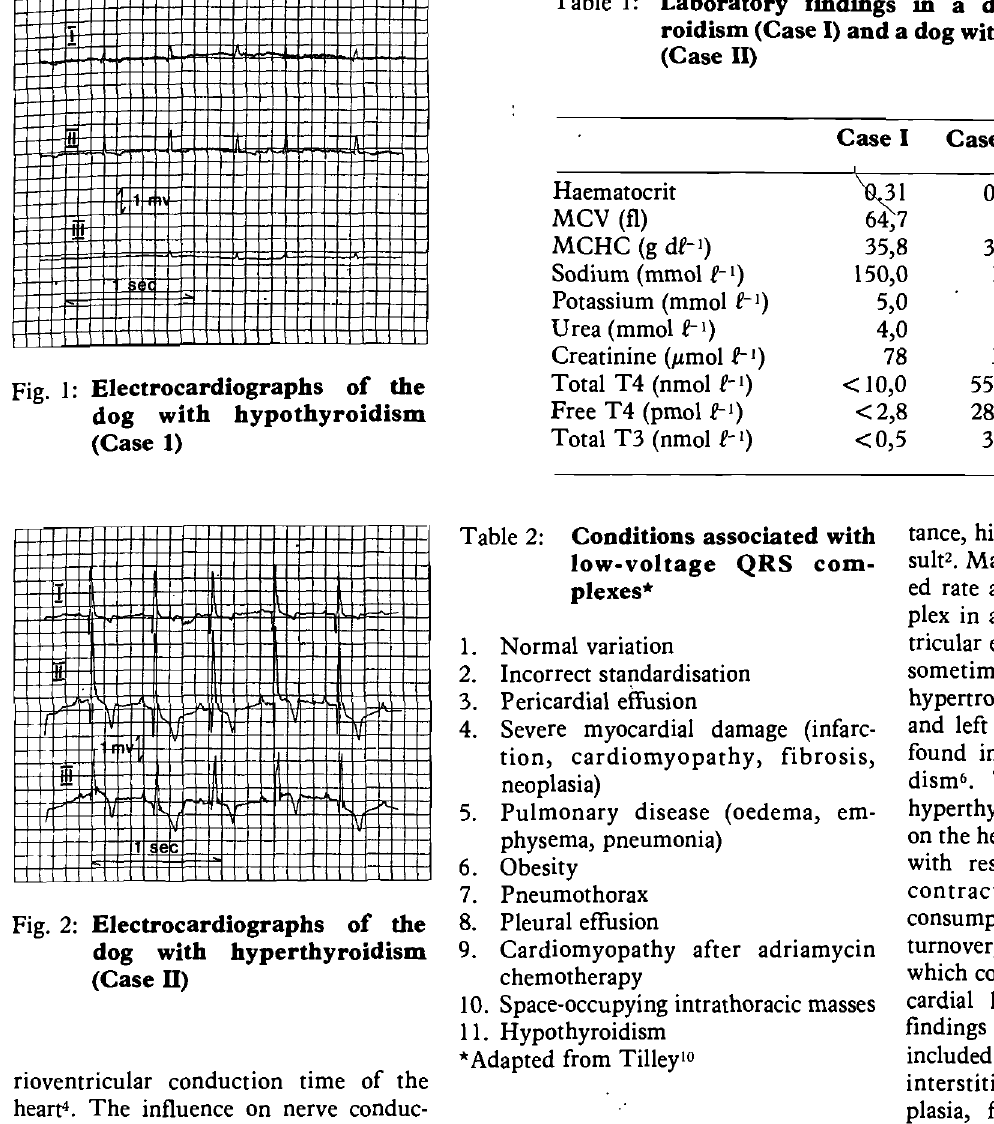
Table 1: Laboratory f"mdings in a dog with hypothy roidism (Case I) and a dog with hyperthyroidism (Case II)